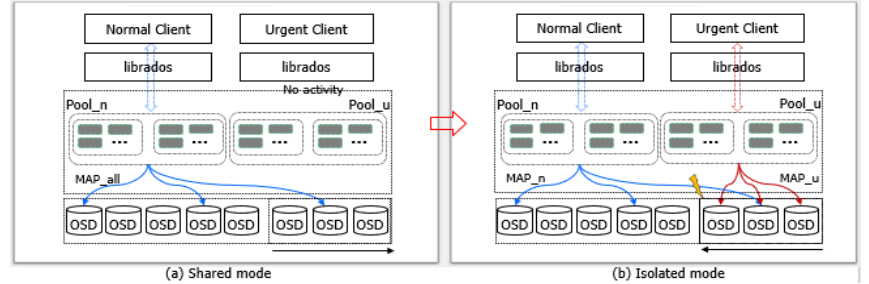
Figure 7. How to orchestrate between the isolated and shared